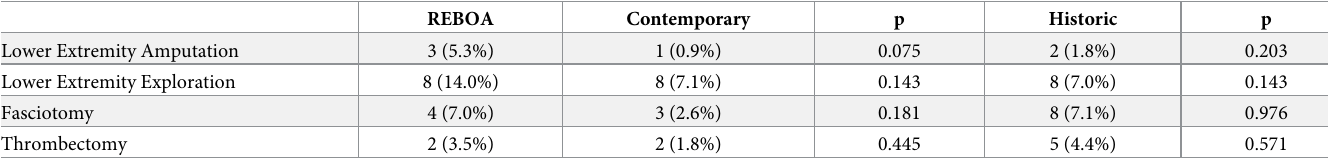
Table 4. Lower extremity complications in REBOA patients by lower extremity AIS score vs No-REBOA